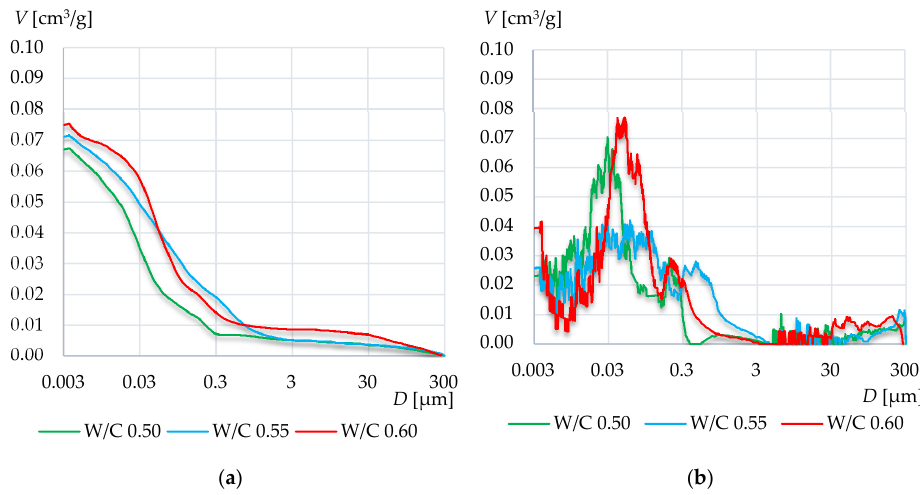
Figure 8. Cumulative distribution volume ( a ) and log-di ff erential pore distribution ( b ) graphs of the mortars based on CEM III A